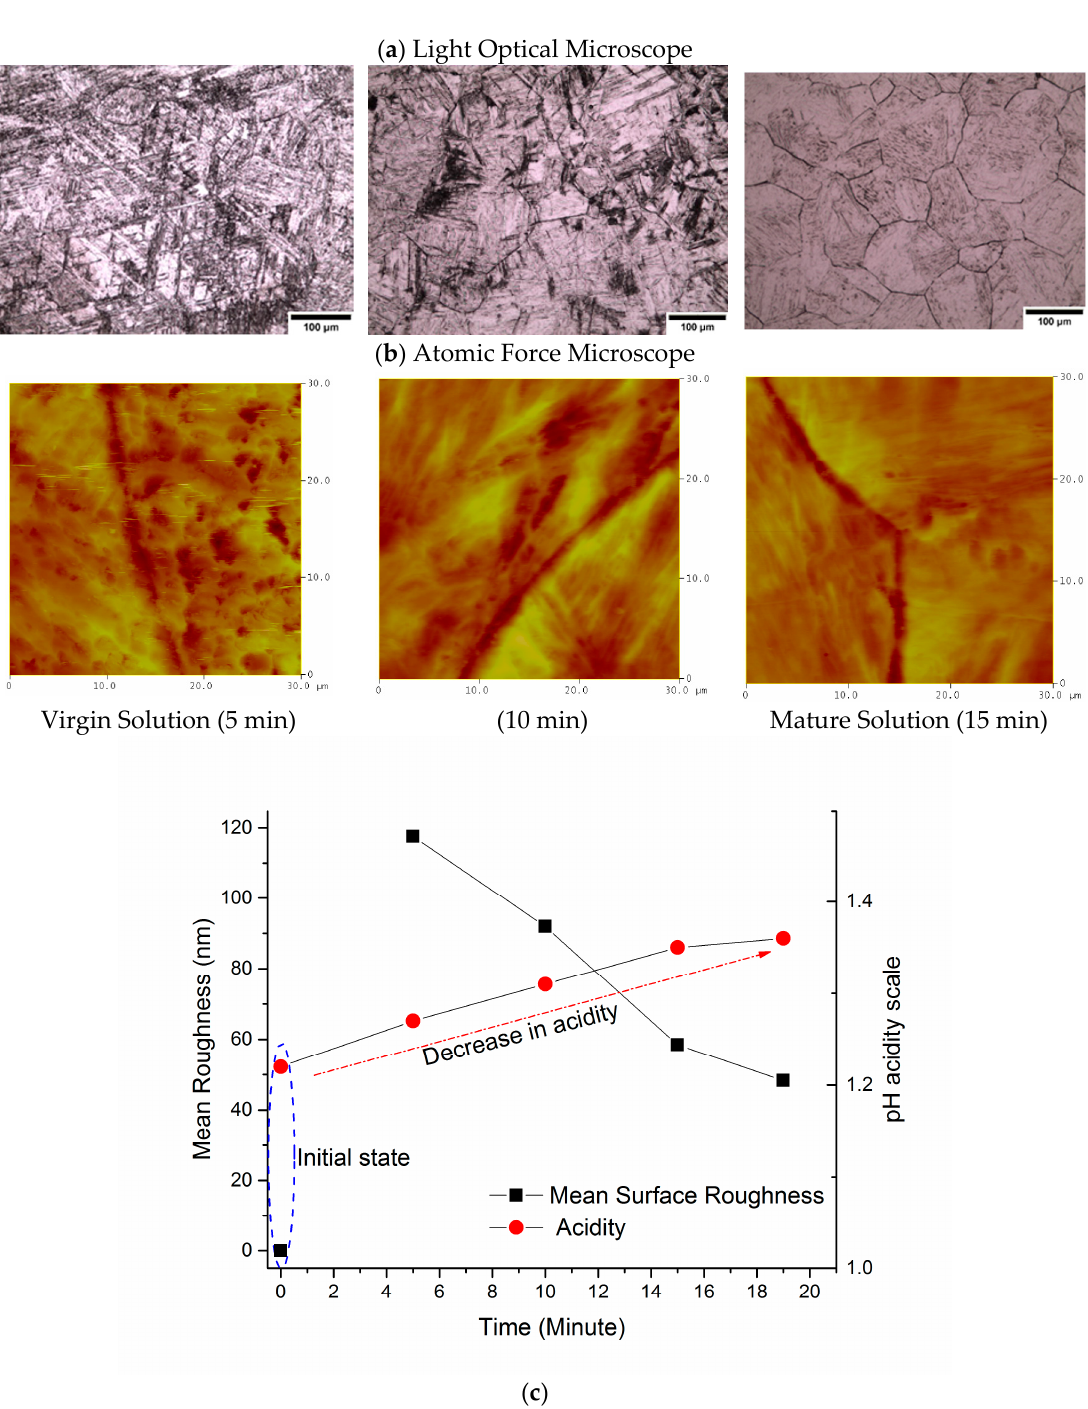
Figure 6. Specimen surface roughness and pH change versus the total time that the etchant solution has been in use. ( a , b ) show optical and AFM micrographs of the specimen surface as a function of the total time the etchant has been in use. The graph in ( c ) shows mean surface roughness and pH as a function of the time the etchant has been in use.